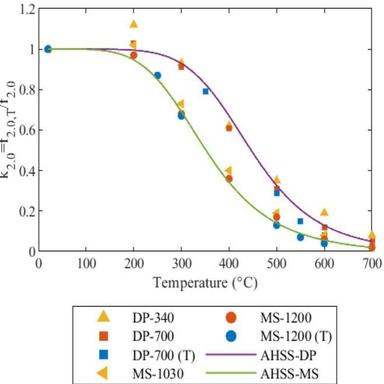
Comparison of proposed retention factors for stress at strain level of 2.0% with test data.